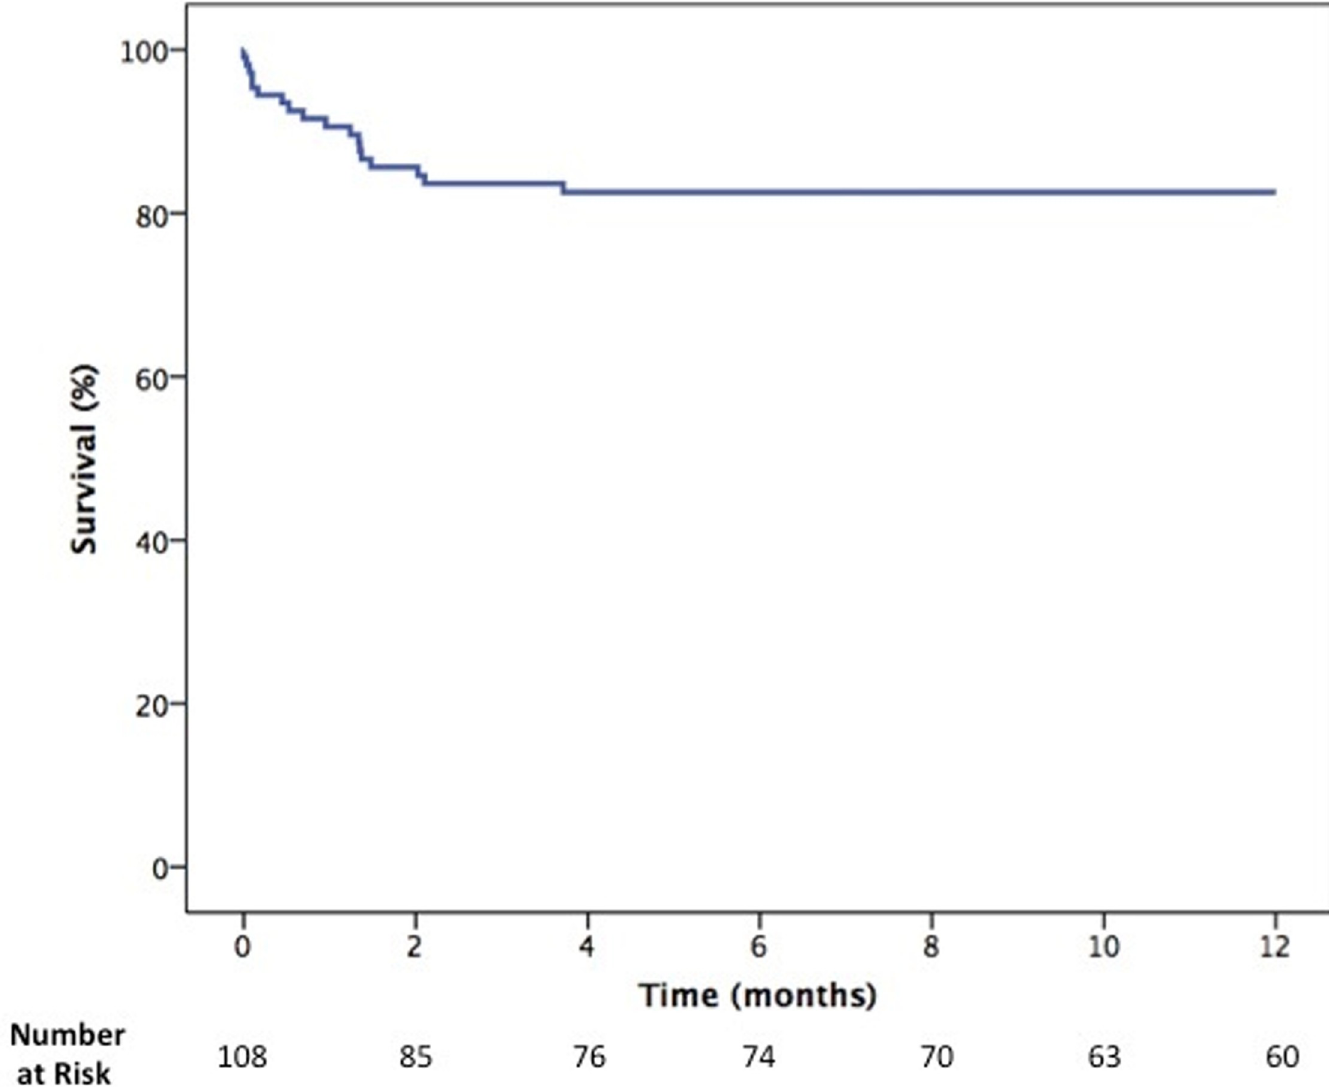
Fig 1. Overall 1-year